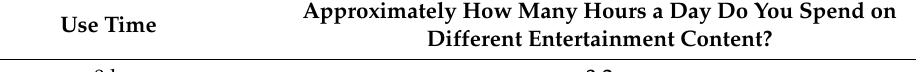
Table 3. Time spent on different entertainment content.